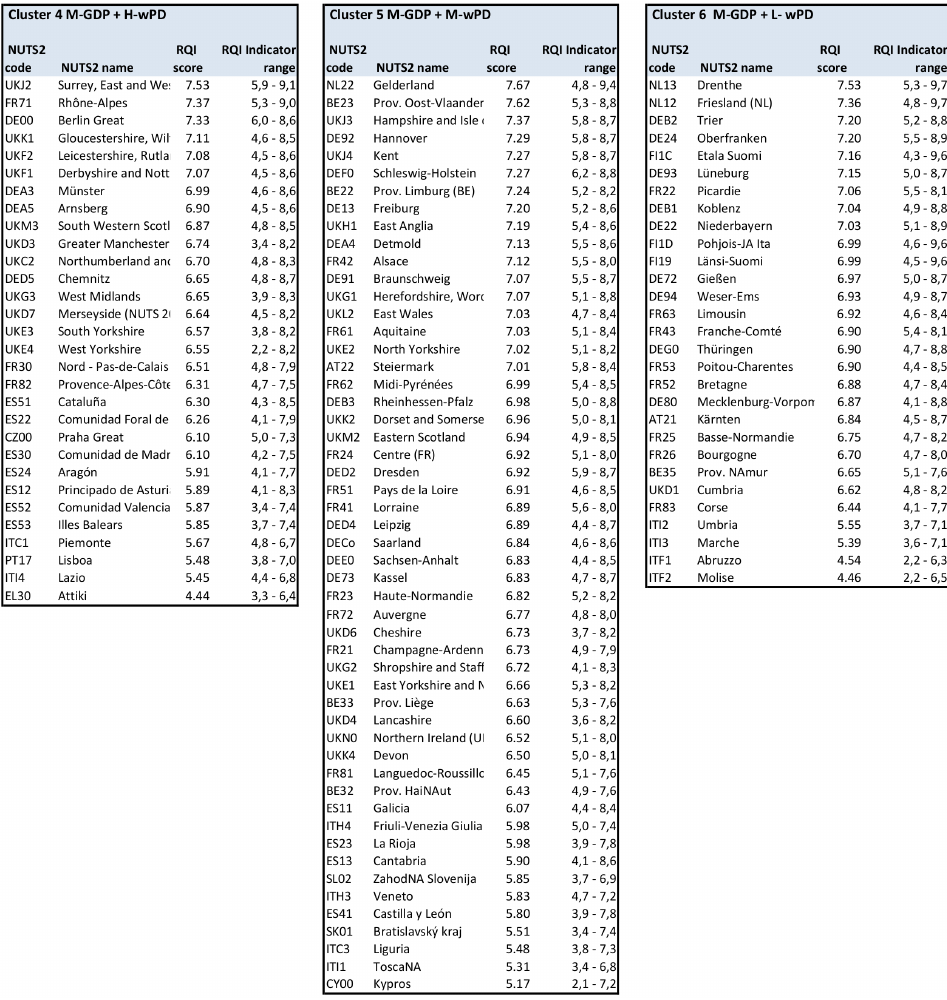
Table A.3: Regions with Moderate GDP